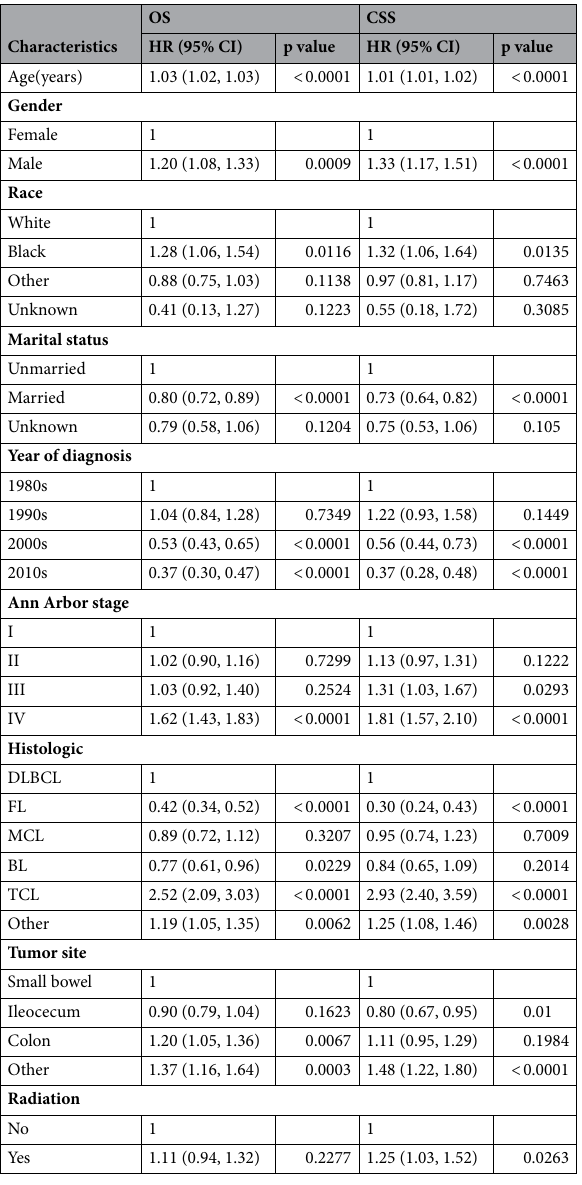
Table 2. Univariate analysis of OS and CSS Cox proportion hazard ratio analysis before propensity score matching. OS overall survival, CSS cancer specific survival, HR hazard ratio, DLBCL diffuse large B cell lymphoma, FL Follicular lymphoma, MCL Mantle cell lymphoma, BL Burkitt lymphoma, TCL T cell